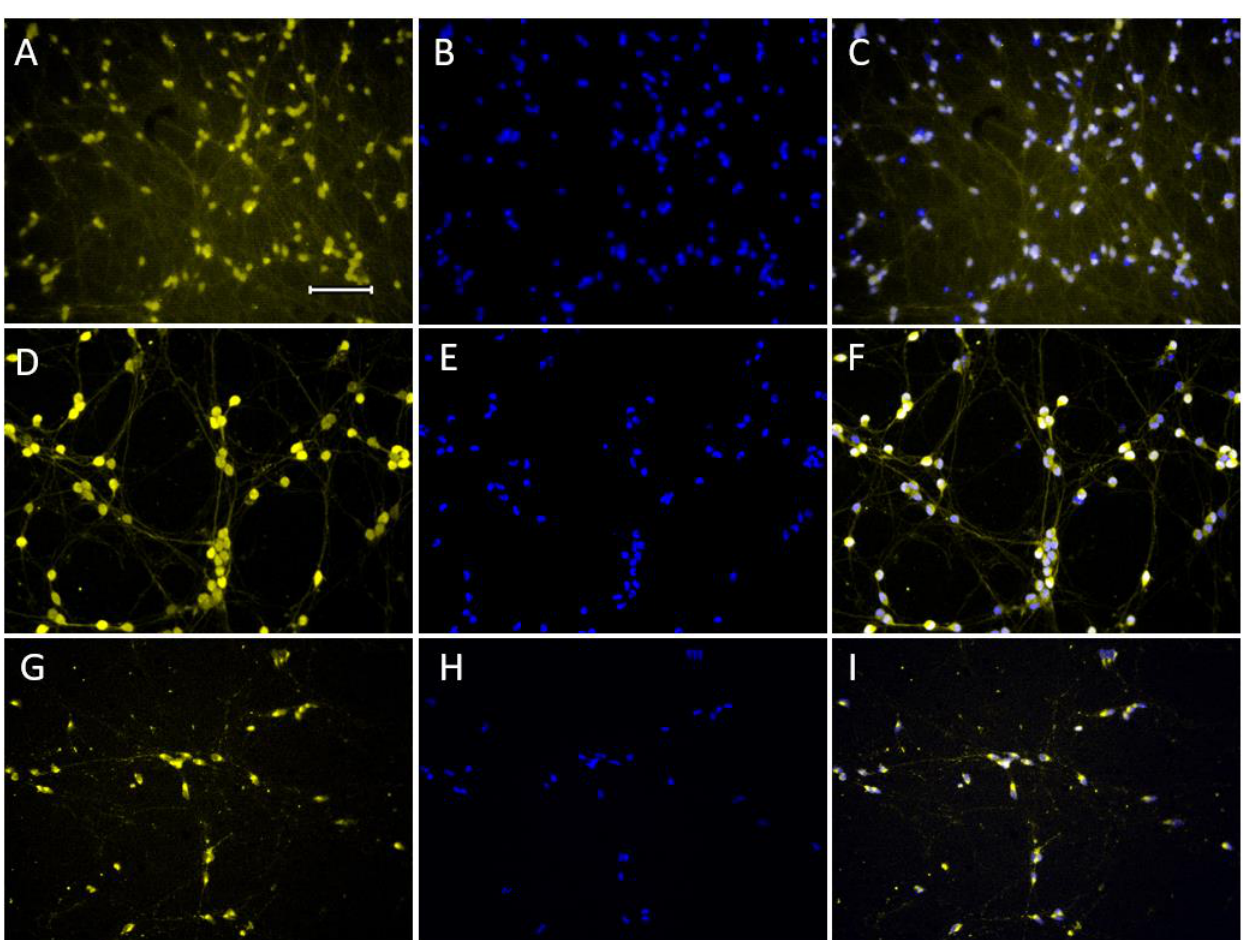
Figure 4. Monoimmunolabeling of LUHMES cells for vesicular monoamine transporter 2 (VMAT2) (( A , C ), yellow) and α -synuclein, monomeric (( D , F ), yellow) and phosphorylated at Ser-129 (( G , I ), yellow). LUHMES cells were additionally stained with 4 ′ ,6-diamidino-2-phenylindole dihydrochlo- ride (DAPI) (( B , E , H ), blue), a nuclear dye. Bar: 100 µm.